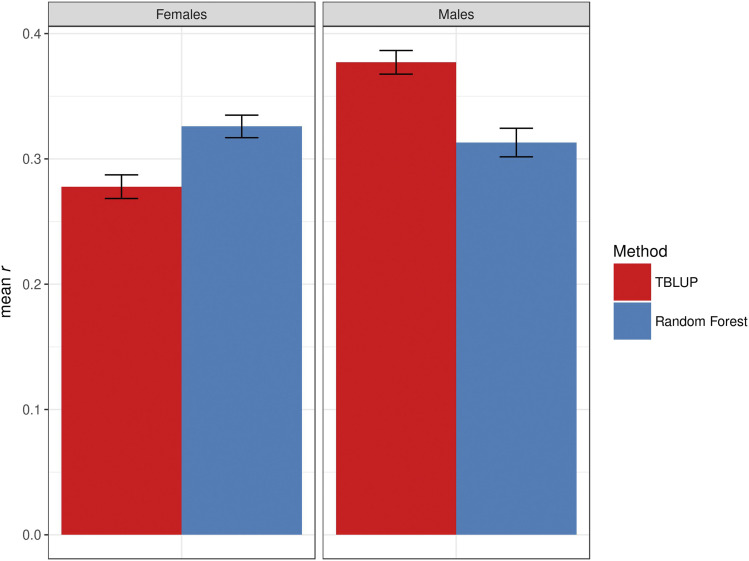
Comparison between the prediction accuracy for starvation resistance, measured as mean r (on the y-axis) in the test set, obtained by TBLUP and Random Forest. The bars represent the standard error of the mean. The left panel represents females, and the right panel represents males.